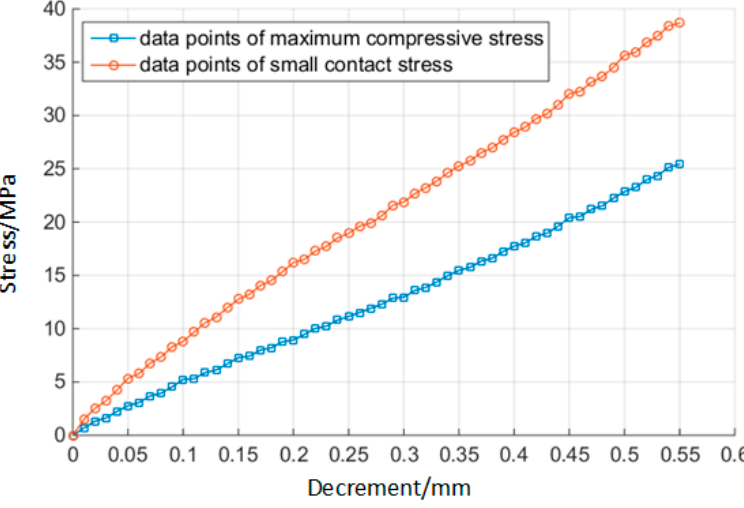
Figure 11. The maximum compressive stress and the small contact stress vary with decrement.